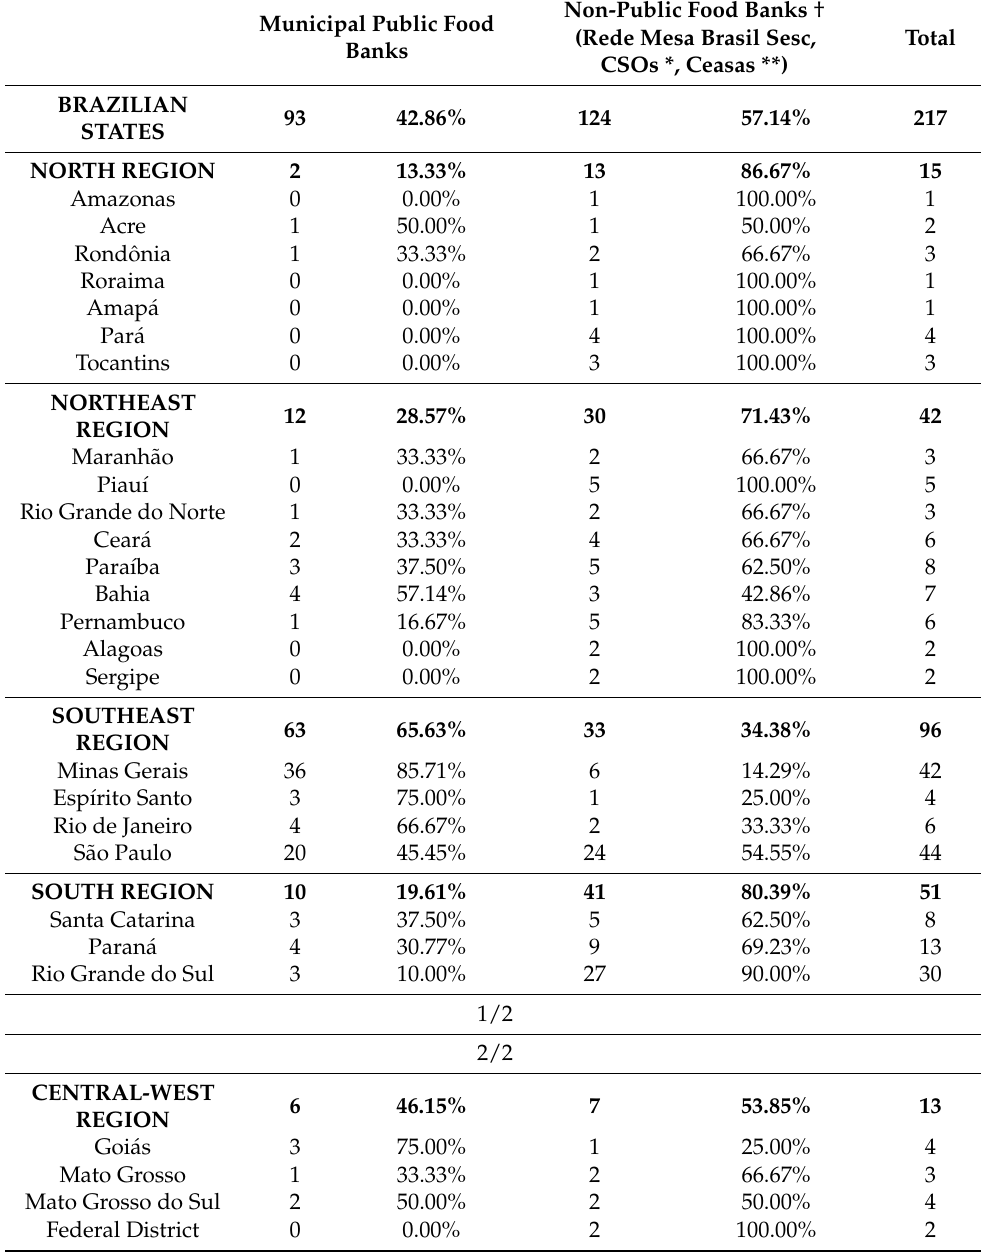
Table 1. Distribution of food banks in Brazil, by region and by state, in 2019 ( n =